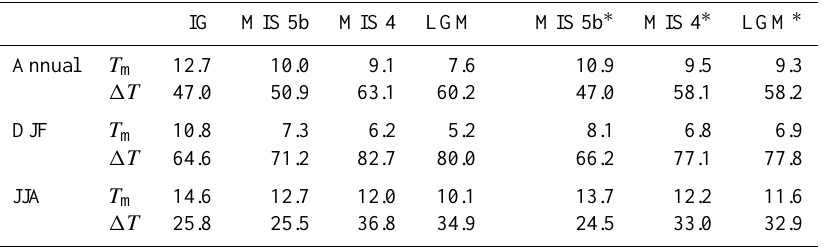
Table 3. Global-mean surface temperature T m ( ◦ C) and Northern Hemisphere Equator–pole (average from 0–10 to 80–90 ◦ N) temperature difference 1T ( ◦ C) for the four time slices. Asterisks indicate sensitivity simulations employing interglacial